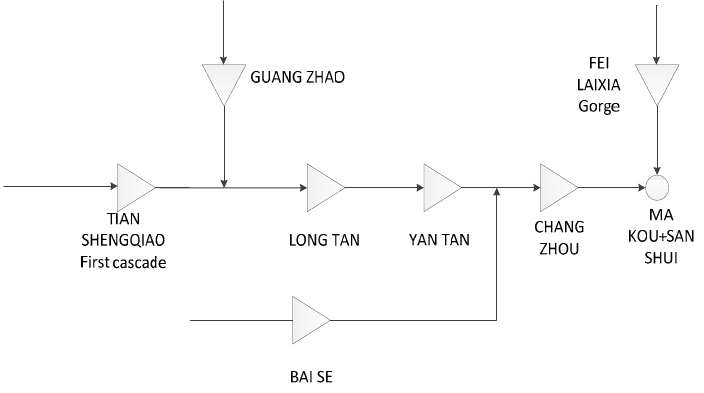
Figure 7. Linkage of key reservoirs in the Pearl River Basin.